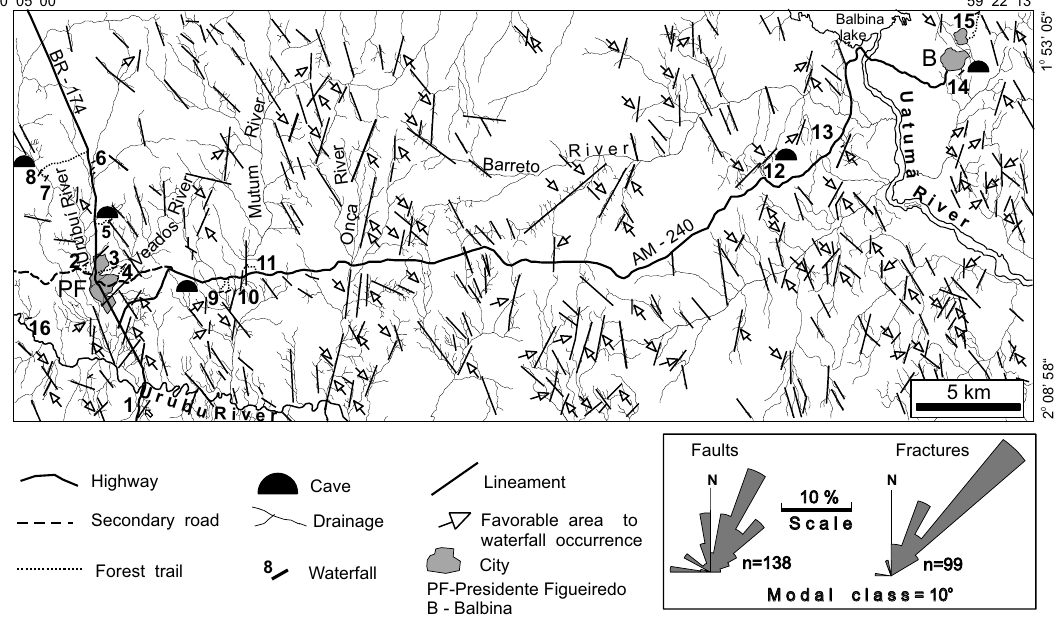
Fig. 2 – A drainage and lineament map of the study area, showing favorable areas for occurrence of waterfalls (arrows). The numbers on the map correspond to the waterfalls: 1) Suframa; 2) Onça; 3) Santa Cláudia; 4) Orquídeas; 5) Arcos; 6) Lajes; 7) Araras; 8) Iracema; 9) Berro D’Agua; 10) Santuário; 11) Portal das Cachoeiras; 12) Pedra Furada; 13) Paredão; 14) Bica; 15) Suçuarana, 16) Rio Branquinho. The rose diagrams in the lower right of the map show the faults and fractures measured in the studied